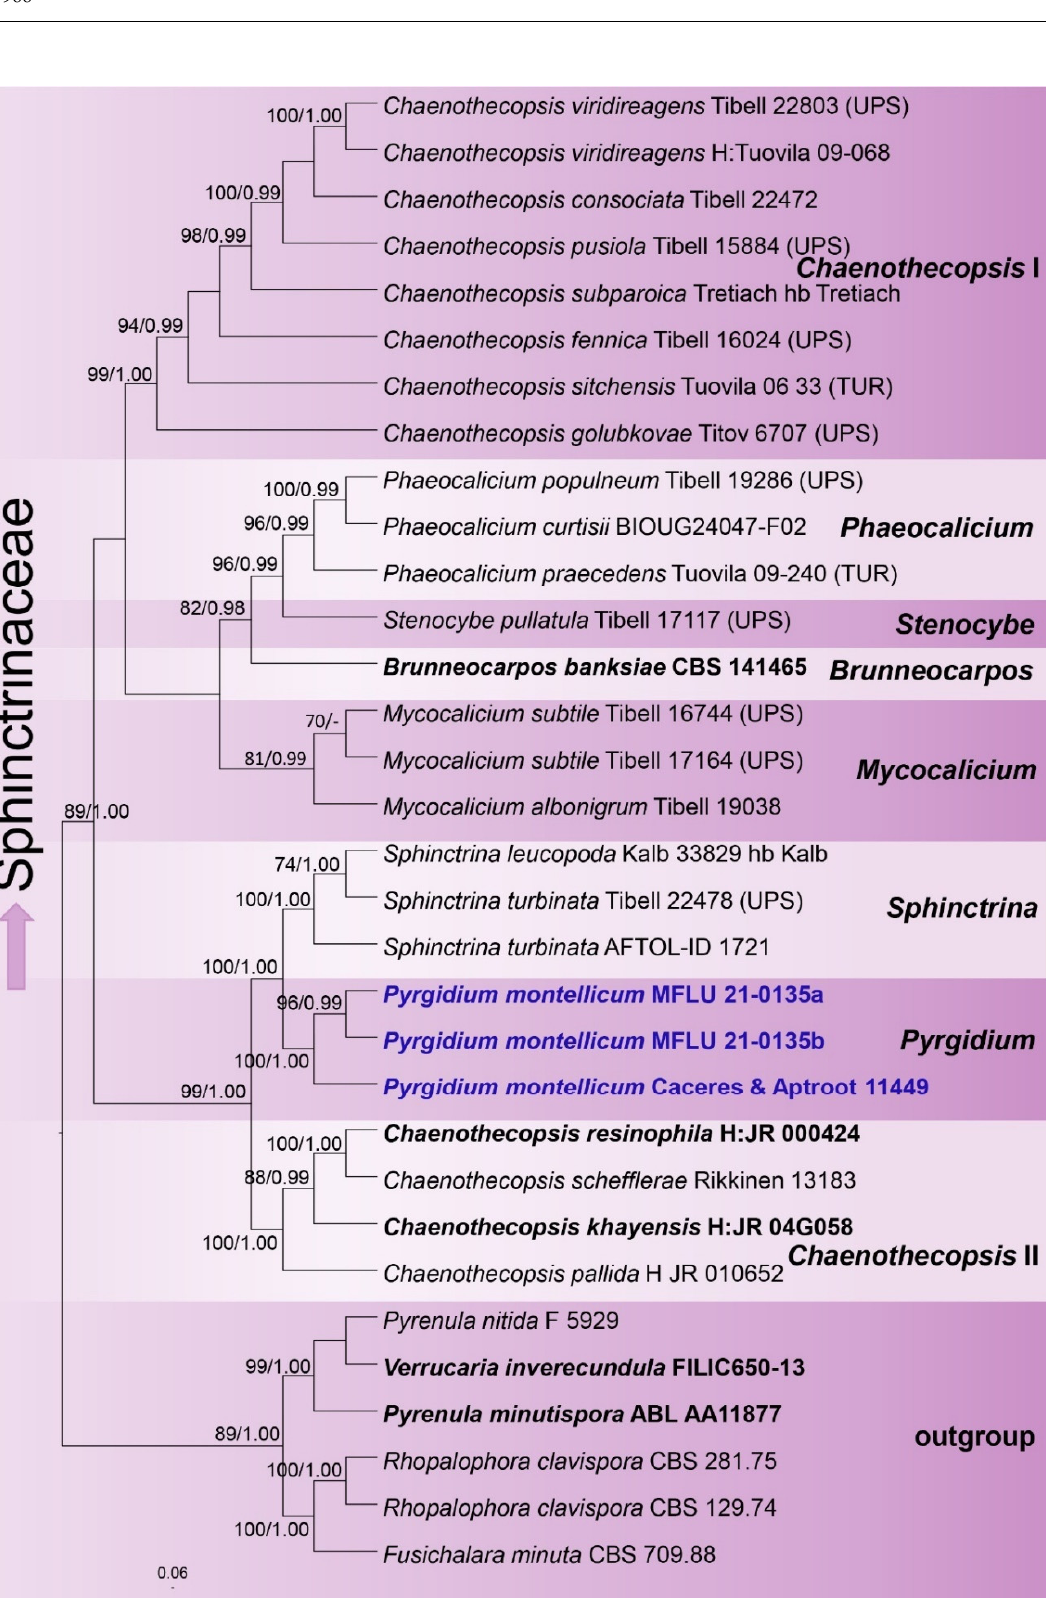
Figure 1. Best-scoring ML tree based on the analysis of the combined LSU and ITS sequence data. Bootstrap support values equal to or greater than 70% and Bayesian posterior probabilities (BP) equal to or greater than 0.95 are given as ML/BP above the branches next to the nodes. Ex-type strains of genera other than Pyrgidium are displayed in bold, and the new sequences generated in this study are indicated in blue. The tree was rooted with Fusichalara minuta (CBS 709.88), Pyrenula minutispora (ABL AA11877), P. nitida (F 5929), Rhopalophora clavispora (CBS 129.74), R. clavispora (CBS 281.75) and Verrucaria inverecundula (FILIC650-13), following Tibell and Vinuesa [48].